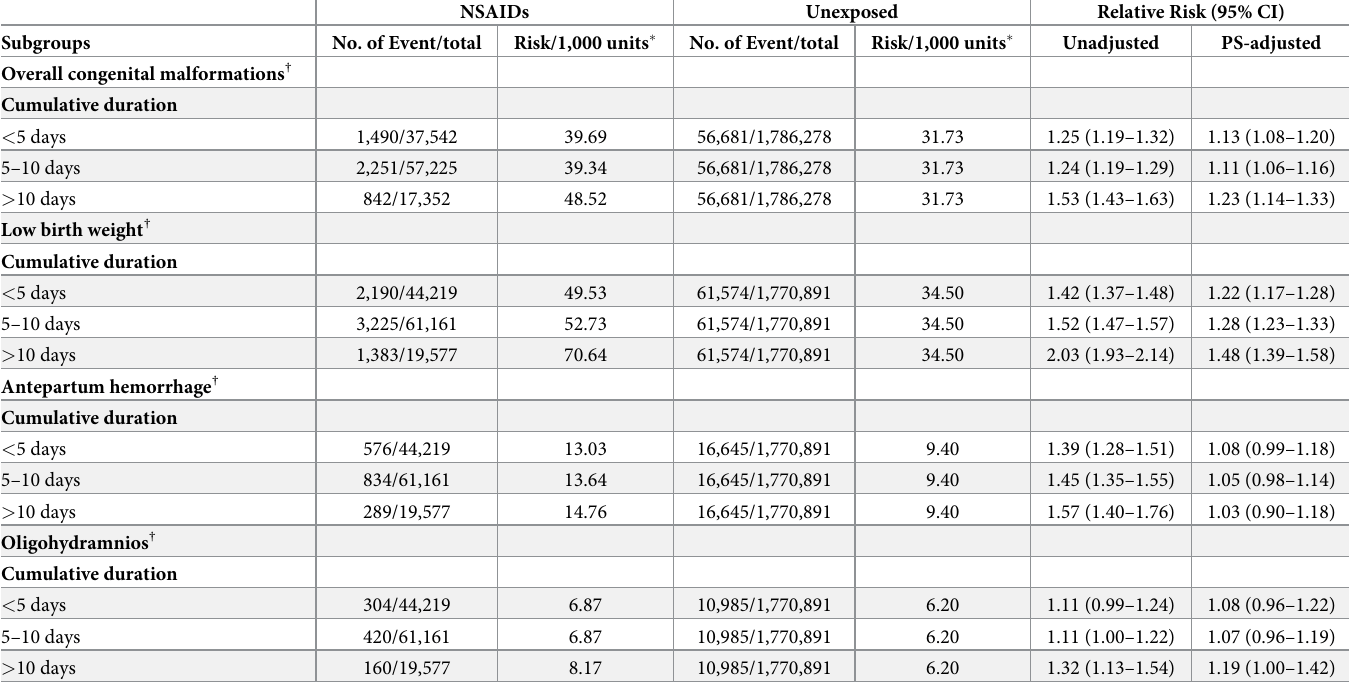
Table 2. Risks of neonatal and maternal adverse outcomes associated with prenatal NSAID exposure during early pregnancy, stratified on the cumulative duration of NSAID use.